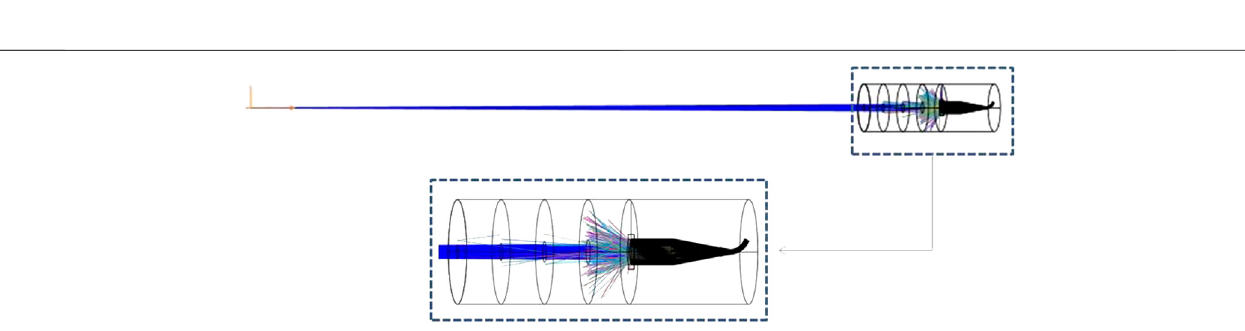
Frontiers in Physics |